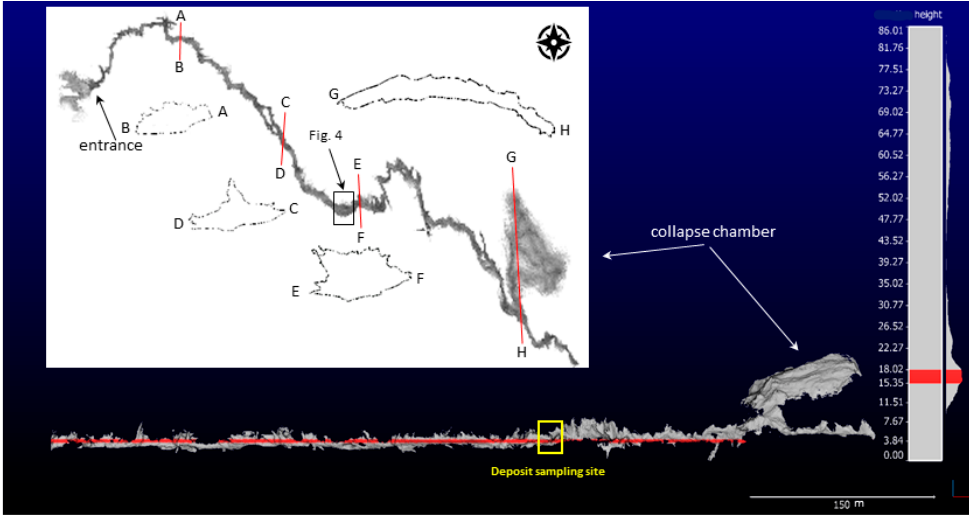
Figure 2. Side view of the 3D point cloud of Selinitsa Cave, with the location of the fine-grained deposit indicated by a yellow square. The thick red line represents the largest space volume of the cave. The embedded figure is a top view of the 3D point cloud of the cave with the respective cross-sections labeled A to H. The height of 3D mapping is given in respect to the present sea level and its histogram.